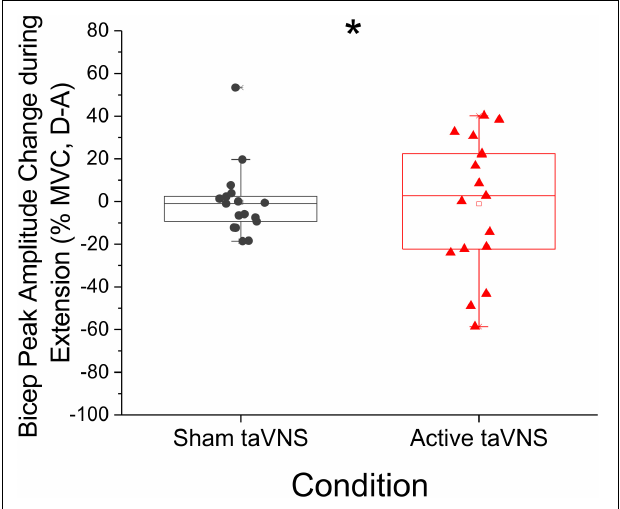
FIGURE 4 | Peak amplitude change score in antagonist (biceps) muscles during extension was notably more dispersed in active taVNS group ( N = 17) compared to the sham group ( N = 17) at discharge (% mean voluntary contraction change score ± SEM). The change in bicep peak RMS amplitude during extension movements was not significantly different between active and sham groups at discharge or follow-up (Mann-Whitney U -test, discharge: P = 0.796, U = 137.0; follow-up: P = 0.183, U = 69.0), but change score variance was significantly different between groups at discharge (Siegel-Tukey test, * P < 0.01).